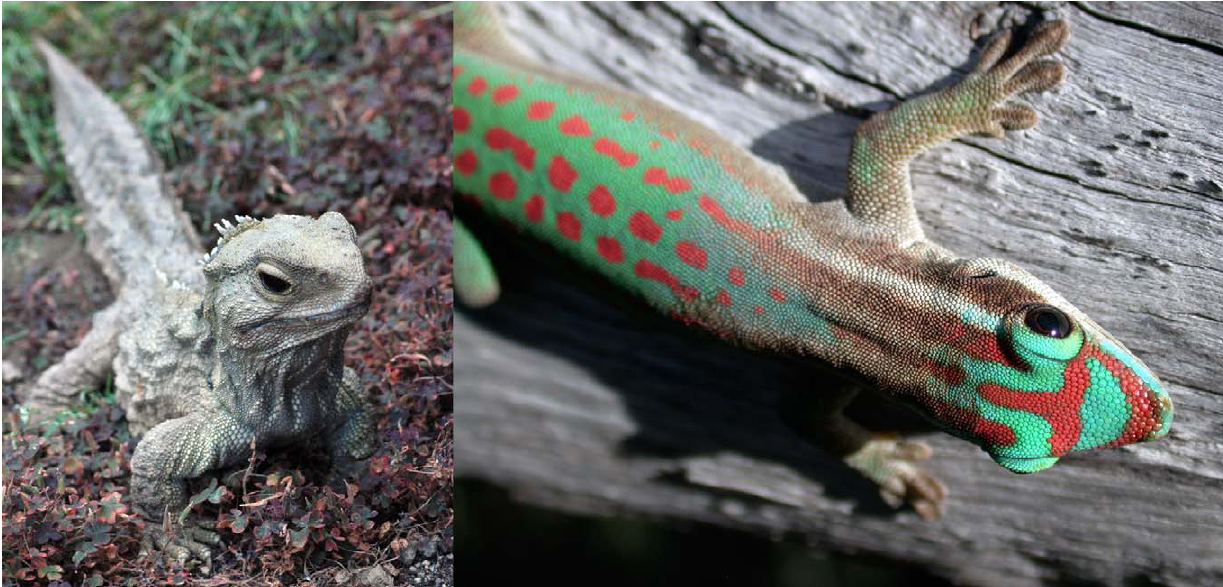
Figure 1. The tuatara ( Sphenodonpunctatus , left) is one of only two surviving species in the clade Sphenodontia. The sister clade to the tuatara is Squamata, which includes the , 7,000 living species of snakes and lizards, including the ornate day gecko ( Phelsuma ornata , right). (Left) from Wikimedia commons, taken by user KeresH, http://commons.wikimedia.org/wiki/File:Henry_at_Invercargill.jpg; (Right) by the author.